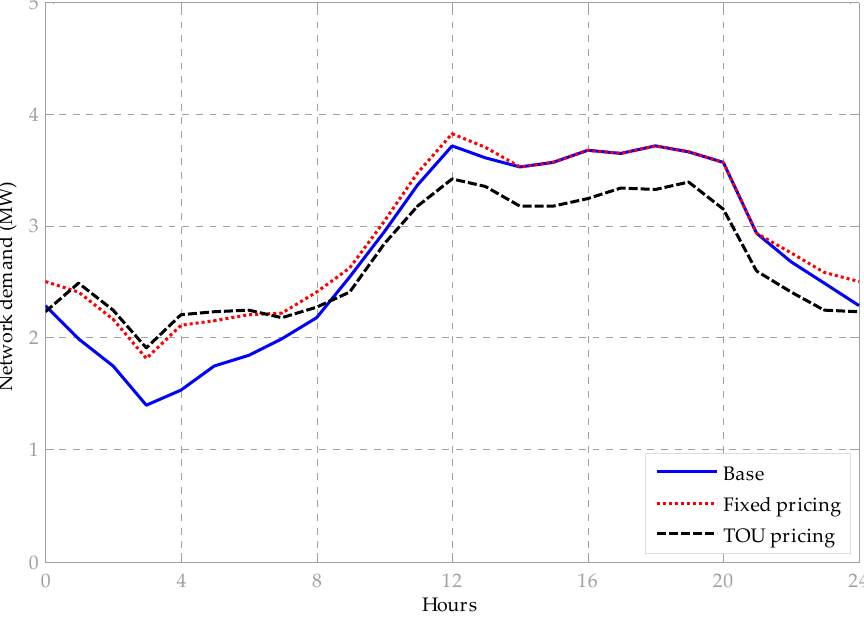
Figure 10. Network 24-hour electrical demand profile.